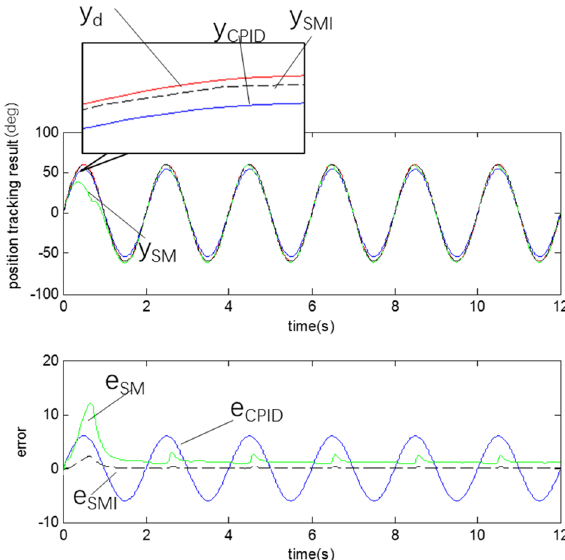
Figure 13. Trajectory tracking result.